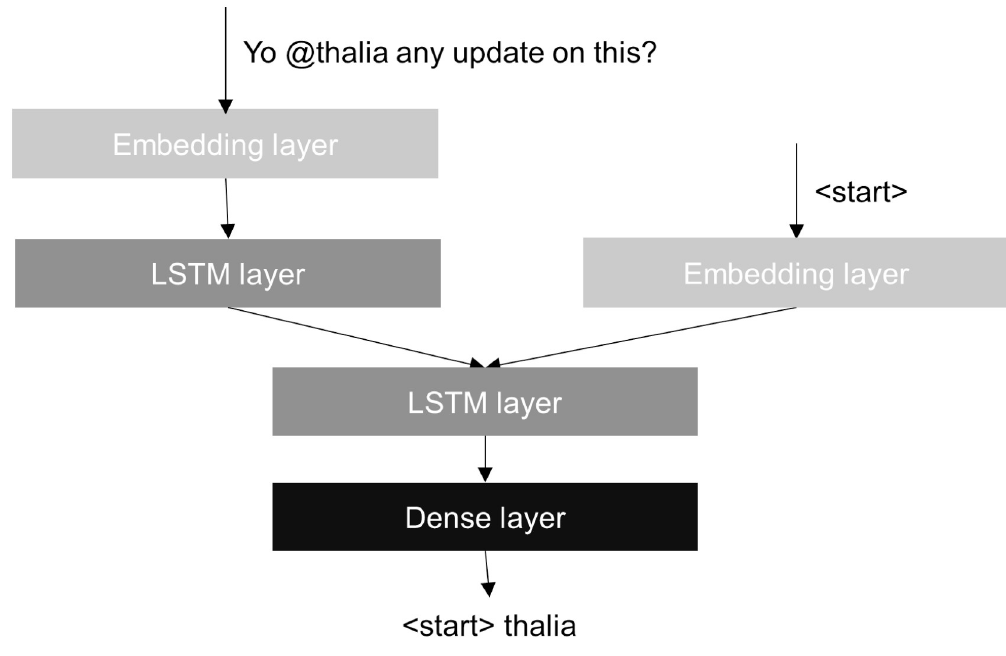
Fig 2. Diagram of the sDAE-like